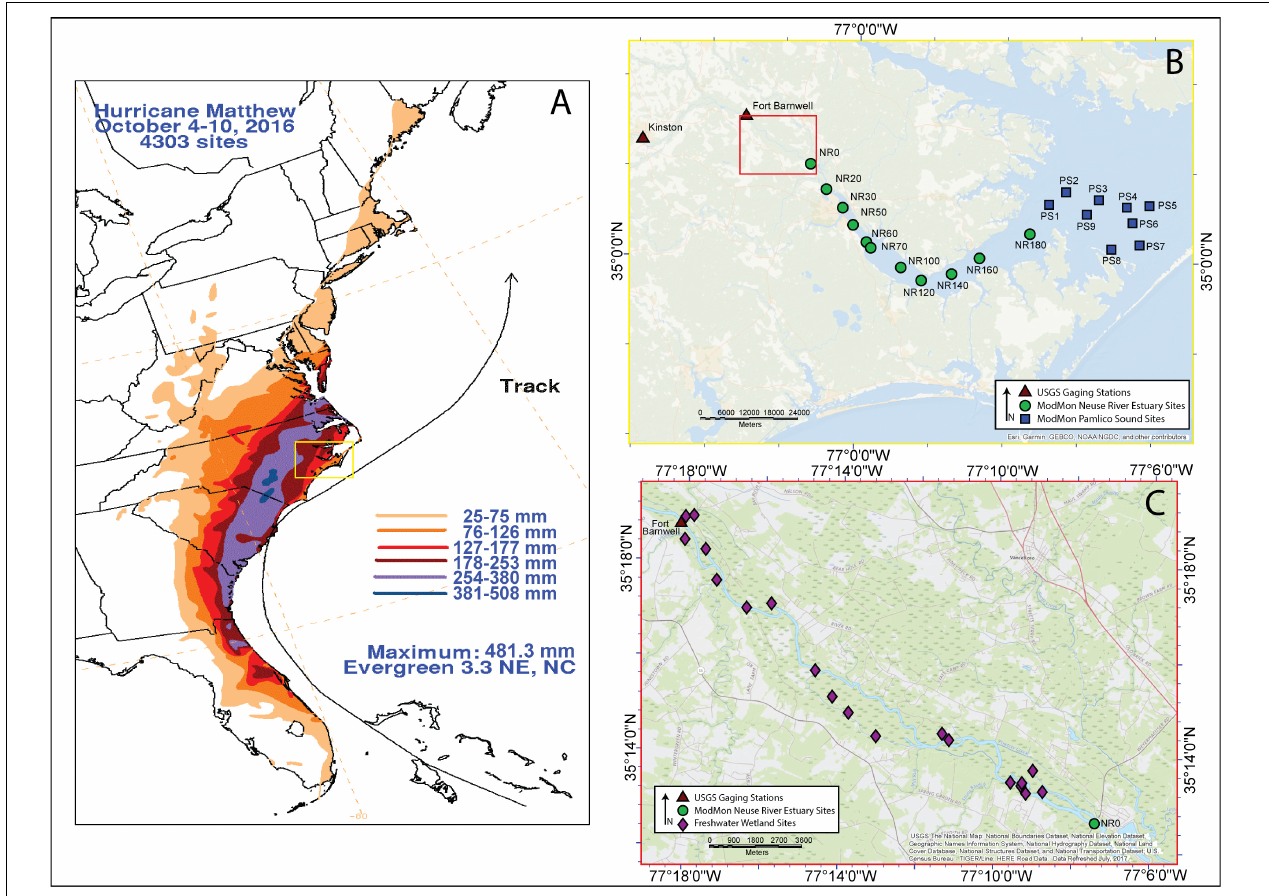
FIGURE 1 | (A) Map from Stewart (2017) showing the rainfall totals and path of Hurricane Matthew during the period of 4–10 October 2016; (B) Map of sampling locations in the Neuse River watershed and Pamlico Sound, NC; (C) Map of freshwater riparian wetlands along the lower Neuse River, NC. (Modified from Osburn et al., 2019a with permission from John Wiley and Sons,